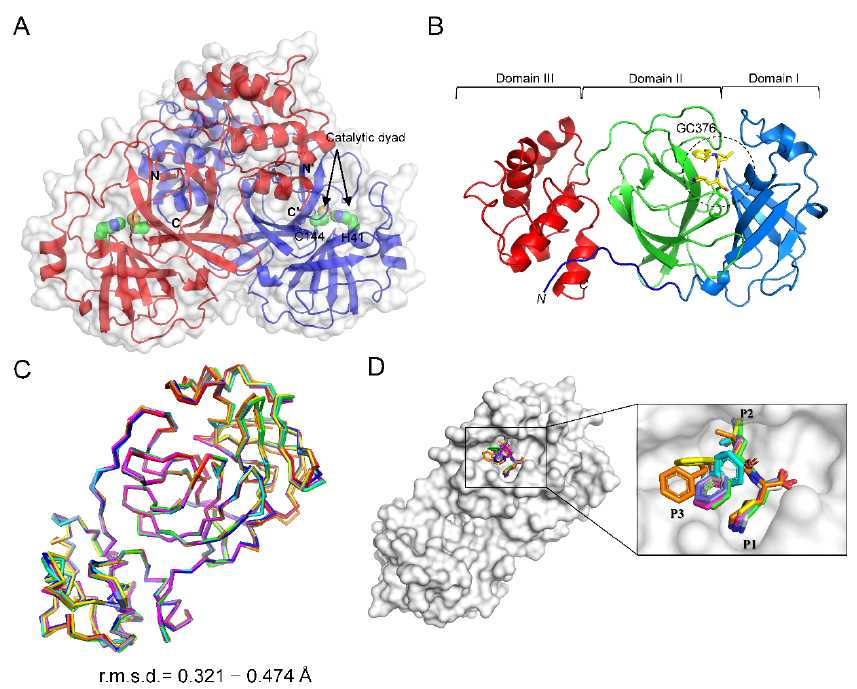
Figure 2. Overall structure of the CCoV M pro in complex with GC376: ( A ) Dimeric assembly of CCoV M pro (red and purple), the catalytic dyad (H41/C144) are shown as green spheres, the N-finger of one protomer extends into the substrate-binding pocket of the other protomer; the N- and C-terminus of each protomer are indicated; ( B ) domain organization of CCoV M pro : N-finger (residues 1–10 (blue)), domain I (residues 11–100 (marine)), domain II (residues 101–198 (green)), and domain III (residues 199–299 (red)), GC376 is shown as yellow sticks; ( C ) superimposition of the C α backbone of the eight different protomers of CCoV M pro in the same asymmetric unit; ( D ) comparison of the GC376 covalently linked to the C144 of eight different protomers of CCoV M pro in the same asymmetric unit.